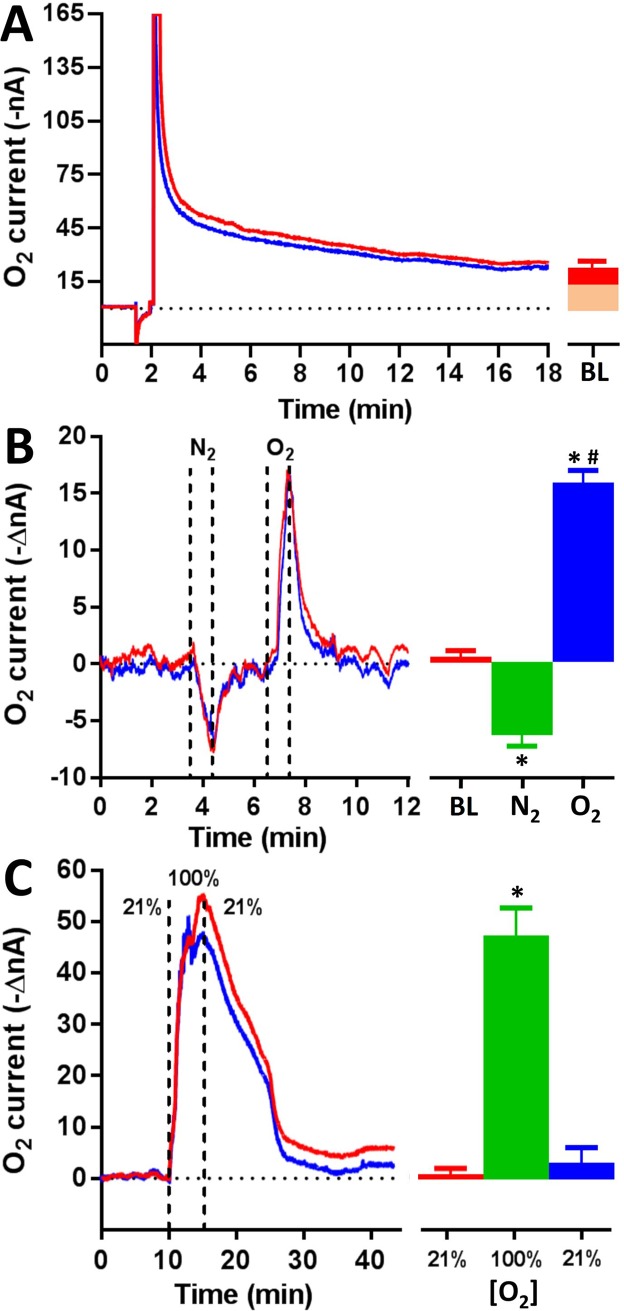
In vivo settling down and effects of N2 and O2 exposure on oxygen currents.The initial stabilization of sensors currents was used for calculating the O2 baseline (A). Only one portion of the signal represents the oxygen current (the red-colored area of the column in A) while the remaining portion (orange-colored area) is the averaged background current of the sensors (see text). The short exposure (1 min) of the cockroach to pure nitrogen (B), determined a significant decrease in O2 currents (* = p <0.01 vs baseline), that returned to baseline values immediately after N2 removal. Conversely, the rapid exposure to pure oxygen (B), caused a short-lasting rise in the oxygen current (* = p<0.01 vs baseline; # = p <0.001 vs N2 exposure). The prolonged exposure (5 min) to pure oxygen, in a sealed chamber, induced a sustained increase (C) increase of the oxygen currents (* = p <0.001 vs baseline) in about half an hour (# = p<0.001 vs O2 exposure). BL = baseline.